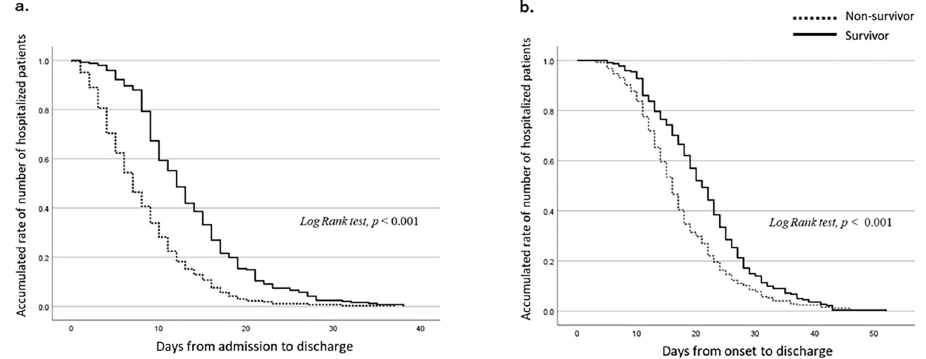
Fig 1. Kaplan–Meier curves showing the number of days from hospital admission to hospital discharge (a.) and the number of days from illness onset to hospital discharge (b.).